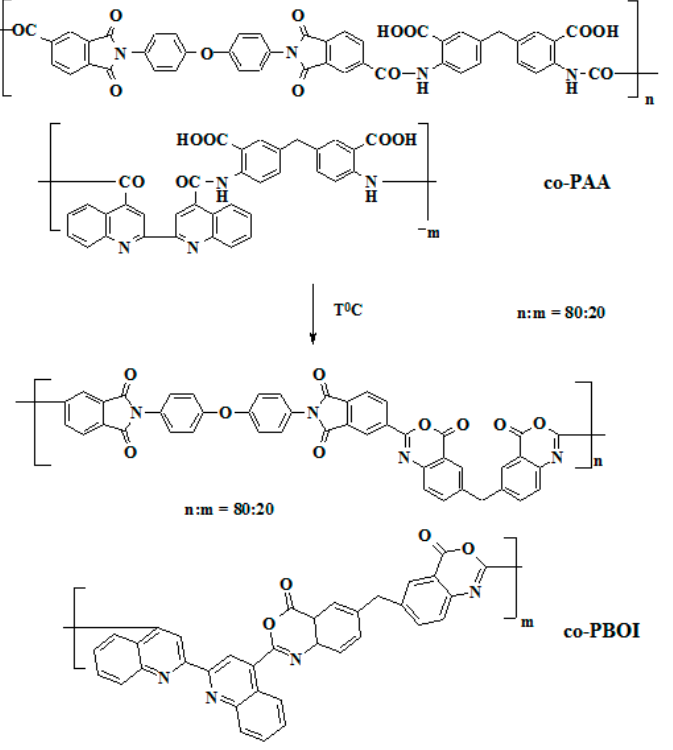
Figure 1. Transformation of the co-PAA into the co-PBOI.